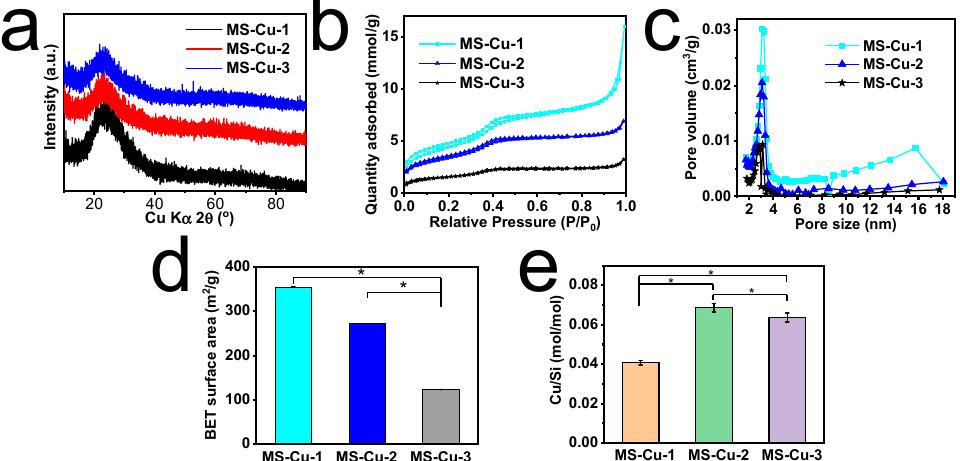
Figure 2. Physicochemical characterization of MS-Cu nanospheres with different particle size. XRD patterns ( a ), N 2 adsorption-desorption isotherms ( b ), pore size distributions ( c ), BET surface areas ( d ), and Cu/Si mol ratio ( e ) of MS-Cu-1, MS-Cu-2, and MS-Cu-3 (*, p < 0.05).